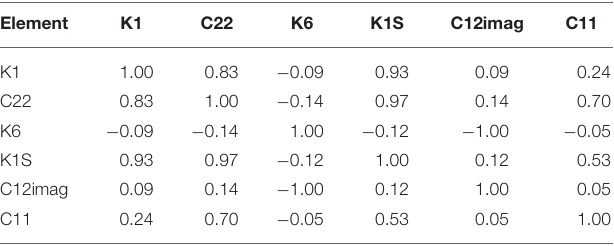
TABLE 6 | Spearman’s correlation coefficients ρ ( α = 0.05), of the topmost important SAR parameters represented by each three elements of the covariance and Kennaugh